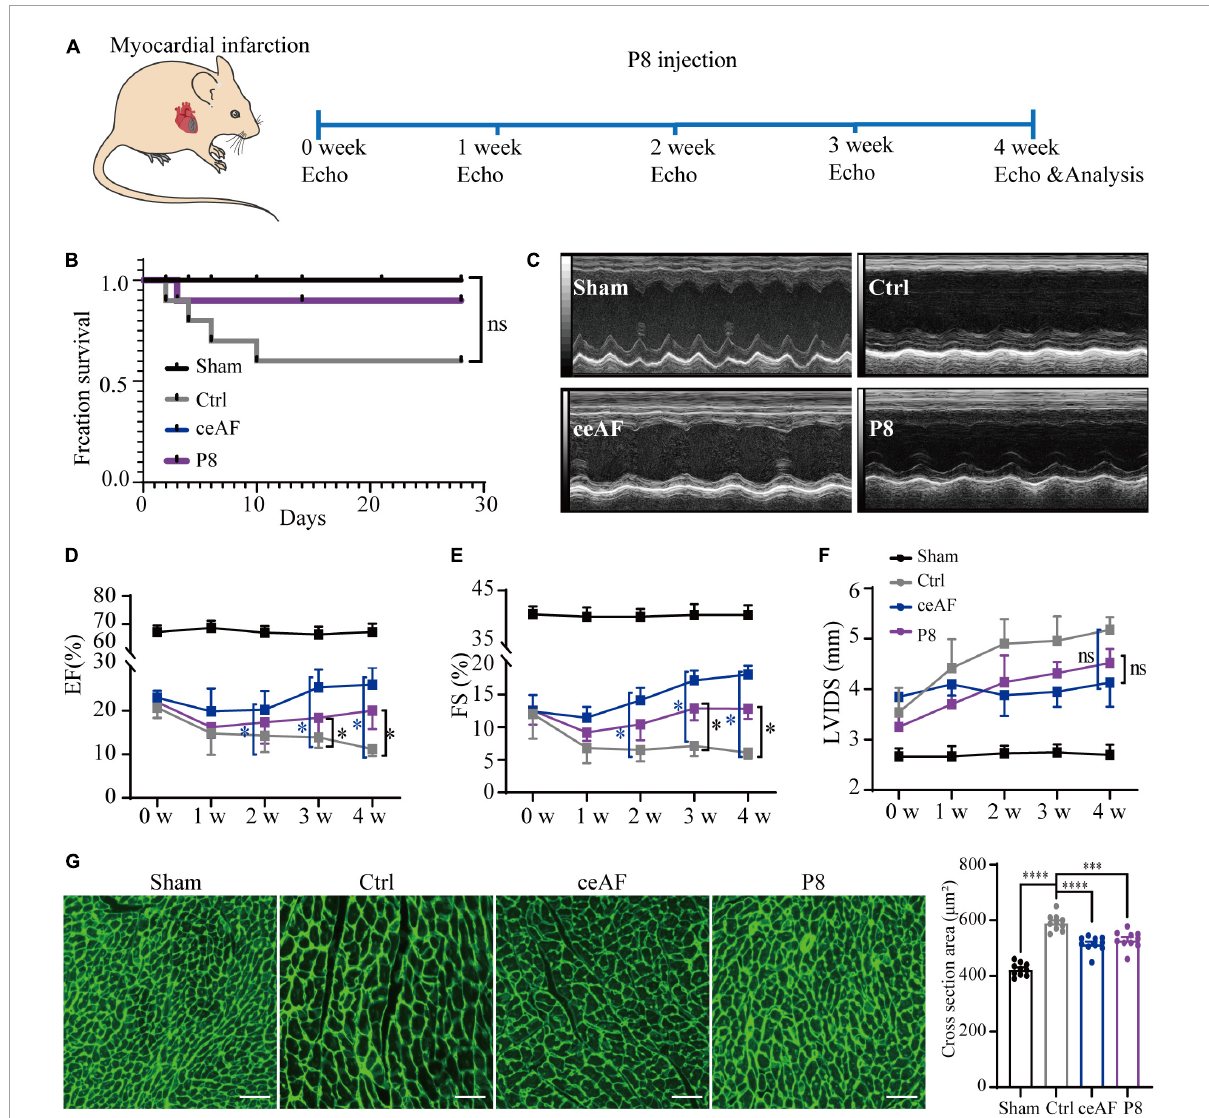
FIGURE1 P8 application improves heart function of MI mice. (A) Scheme illustrating schedule of P8 treatment after MI and echocardiography analysis. (B) Survival curve of Sham, untreated (control) and ceAF and P8 treated mice after MI. n = 10 per group. (C) Representative echocardiography at 4 weeks after MI. Quantitative evaluation of cardiac contractile function (D,E) and cardiac remodeling (F) with 5% glucose (MI control), ceAF and P8 treated mice after MI and sham control mice. The groups of experimental mice are: sham, i.v. injection of 5% glucose (Ctrl), i.v. injection of 5.0 ml/kg of ceAF (ceAF), injection P8 fraction 5.0 ml/kg (P8). n = 6 per group. (G) Representing WGA staining of cardiac cross sectional area post-MI ( n = 10 per group). Scale bar: 50 µ m. * p < 0.05; *** p < 0.001; **** p < 0.0001; ns, not